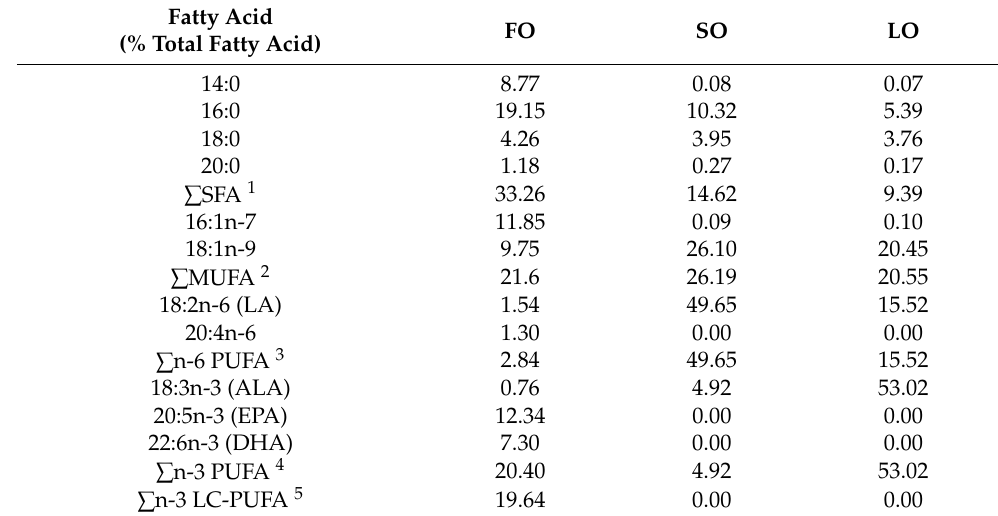
Table 2. Fatty acid composition of the experimental diets (% total fatty acids)